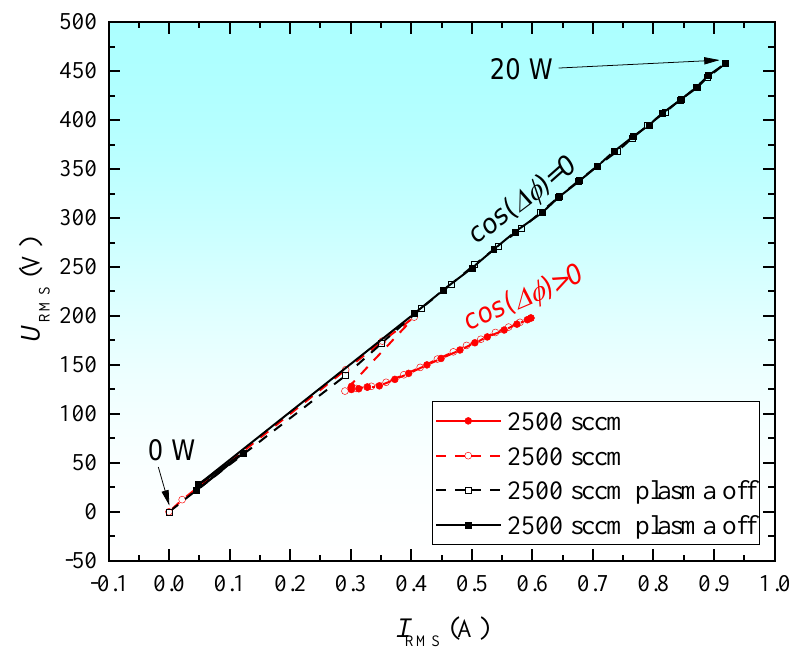
Figure 3. I-V characteristic for discharge configuration with bare electrodes (DBE) discharge (0–20 W, Ar flow 2500 sccm).